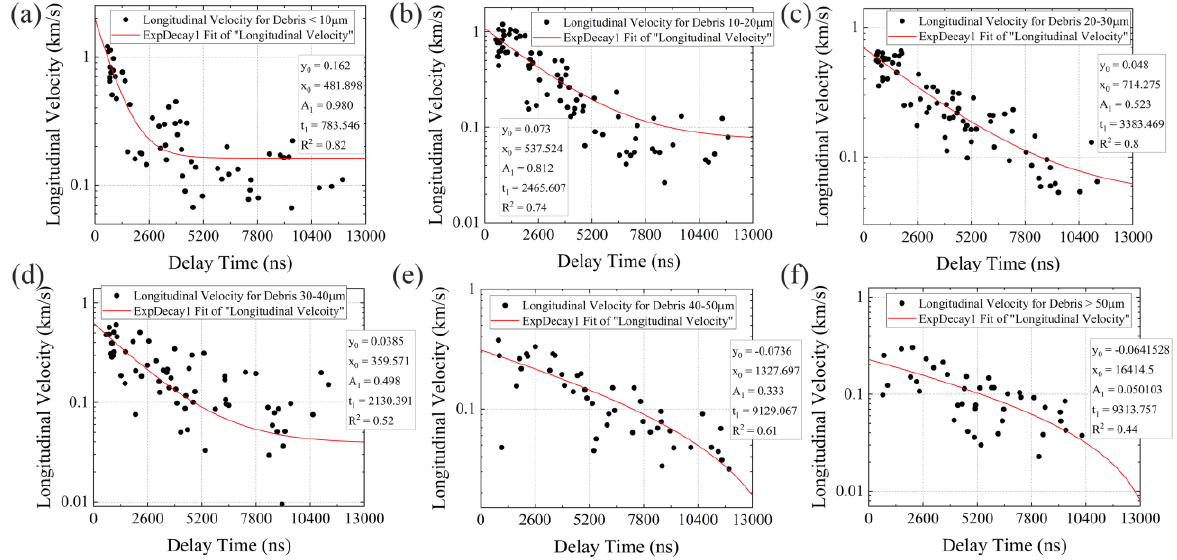
Figure 4. Longitudinal velocity V 0 of particles with different diameters vs. probe time delays ranging from 500 to 12,000 ns, where ( a ) represents particles with diameters <10 μ m, ( b ) 10 – 20 μ m, ( c ) 20 – 30 μ m, ( d ) 30 – 40 μ m, ( e ) 40 – 50 μ m, and ( f ) >50 μ m, red curves represent fit decay functions.